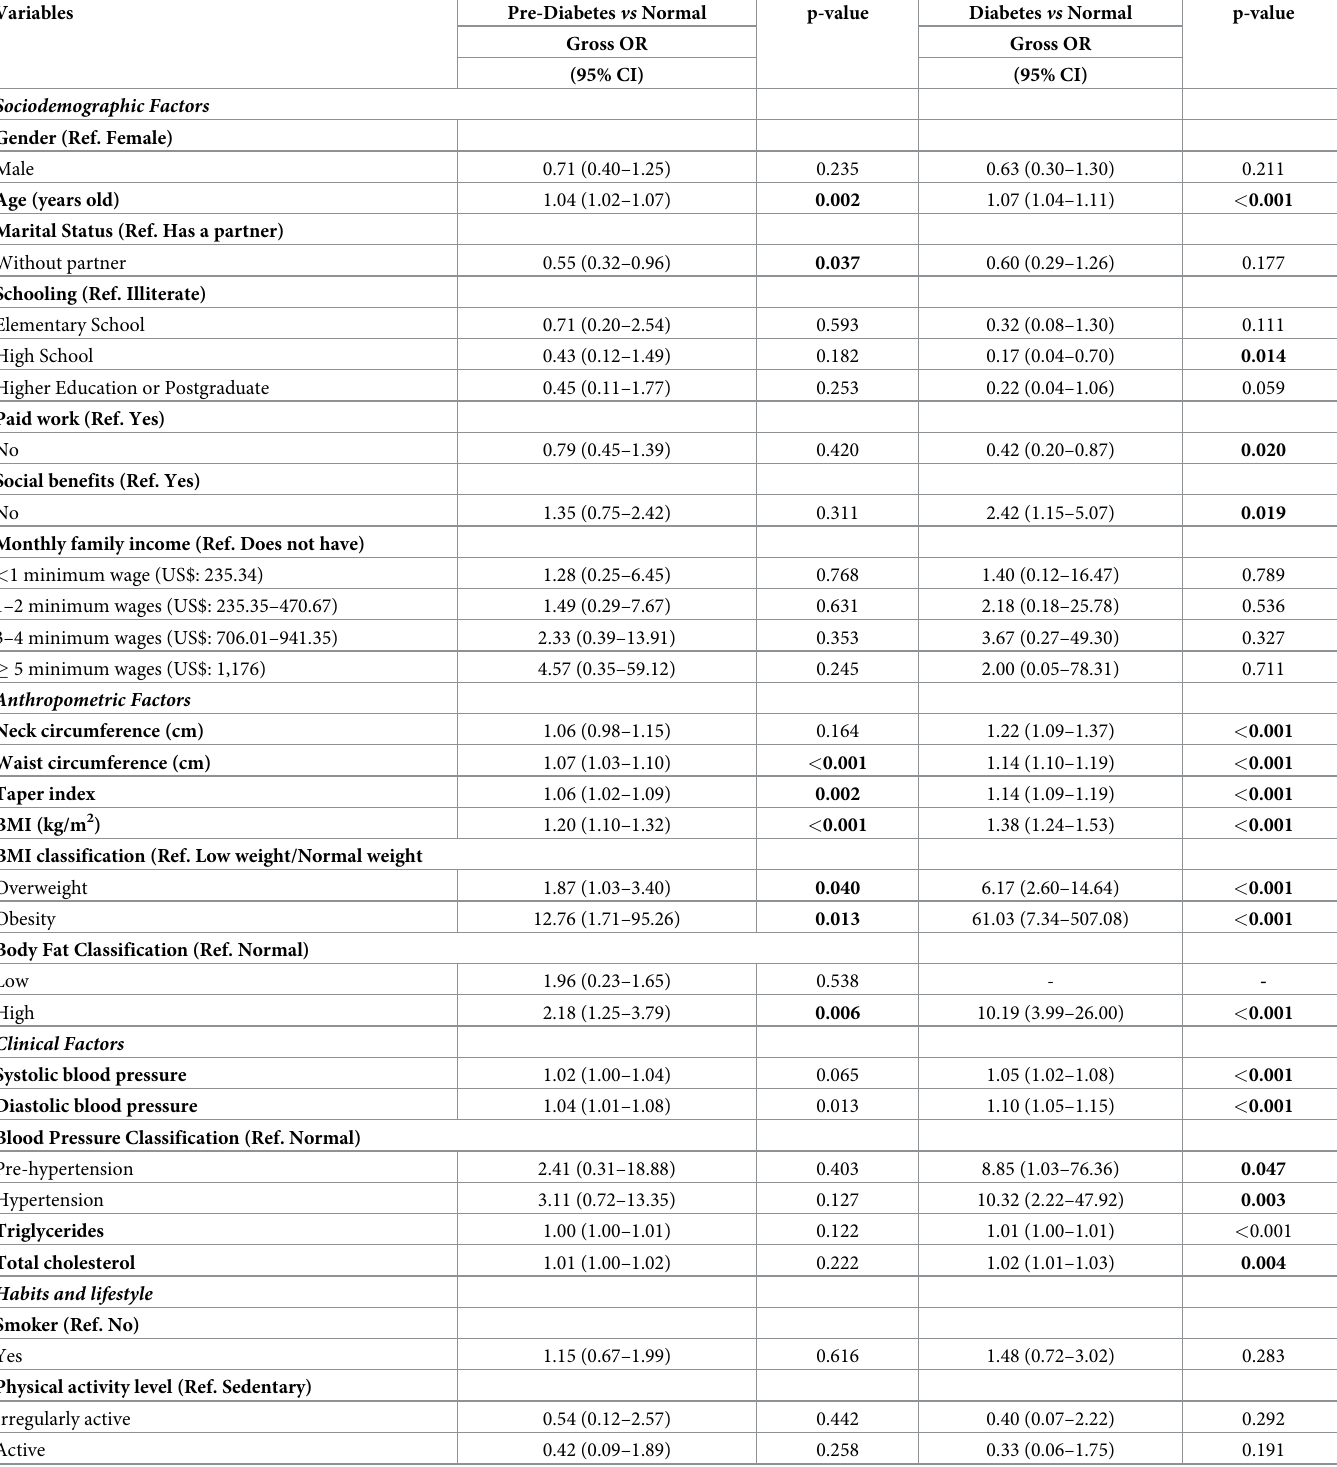
Table 2. Unadjusted odds ratio and Confidence Interval (CI) for sociodemographic and anthropometric variables, clinical factors, lifestyle and family history asso- ciated with pre-diabetes and diabetes among the Munduruku indigenous